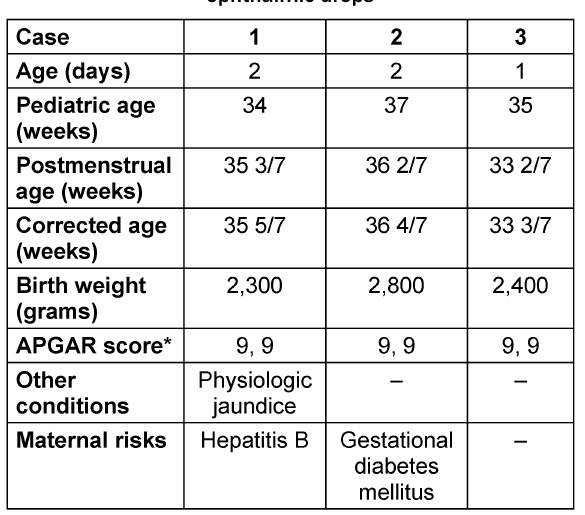
Table 1: Baseline characteristics of preterm neonates